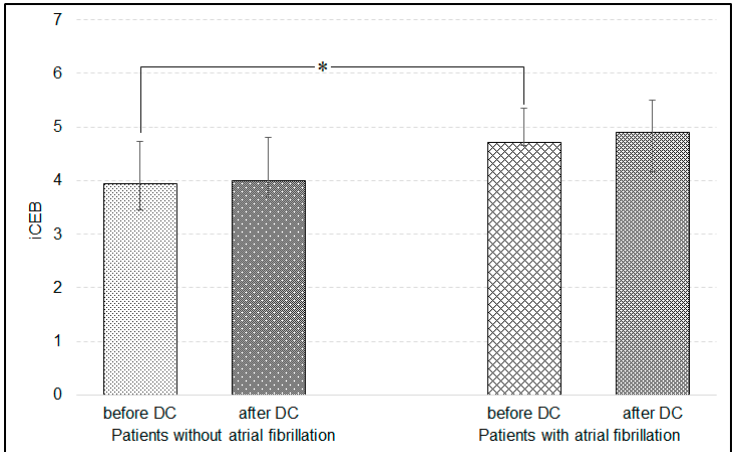
Figure 5. Changes in the index of cardio-electrophysiological balance (iCEB) after compared to before decompressive craniectomy (DC) in relation to episodes of atrial fibrillation observed within a few days after DC. * p < 0.05—difference in iCEB before DC between patients with and without atrial fibrillation (Mann–Whitney U-test).